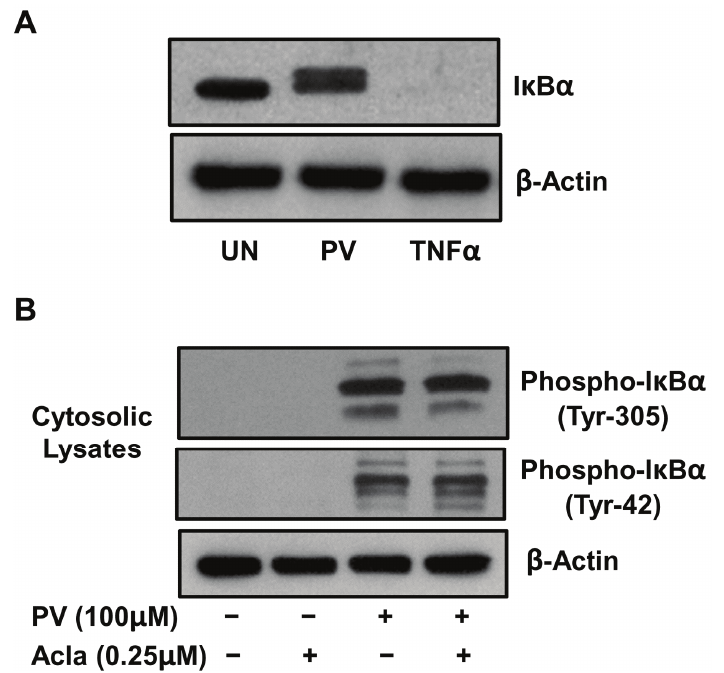
Figure 1. Pervanadate (PV) stimulation induces tyrosine phosphorylation of I(cid:2)B(cid:3) but not its proteolytic degradation. ( A ) ILU-18 cells were either left untreated or treated with Pervanadate (100 (cid:4)M) or TNF-(cid:3) (20 ng/mL) for 20 min. At the end of treatment, cytosolic lysates were obtained and 30(cid:4)g protein from each lysate was resolved by sodium dodecyl sulfate polyacrylamide gel electrophoresis (SDS-PAGE). Resolved proteins were detected by Western blotting using antibody to nuclear factor of kappa light polypeptide gene enhancer in B-cells inhibitor, alpha (I(cid:2)B(cid:3)) and enhanced chemiluminescence (ECL). The blot was stripped and re-probed with antibody to (cid:5)-actin to ensure equal protein loading. ( B ) ILU-18 cells were treated with PV (100 (cid:4)M) for 20 min, with or without prior treatment with Aclacinomycin [Acla] (0.25 (cid:4)M) for 2 h. At the end of incubation, cells were washed and cytosolic lysates prepared. As controls, cell lysates were made from ILU-18 cells either left untreated or treated for 140 min with 0.25 (cid:4)M Aclacinomycin alone. Lysates, equalized for 30 (cid:4)g protein, were resolved using SDS-PAGE, followed by Western blotting using a phospho-specific antibody recognizing I(cid:2)B(cid:3) (Tyr-42) or (Tyr-305). After stripping, the blot was re-probed with antibody to (cid:5)-actin to demonstrate equal protein loading. To elucidate whether PV-mediated NF-(cid:2)B activation occurs by a mechanism involving tyrosine phosphorylation, we next assessed if both in the absence and presence of proteasome inhibitor (Aclacinomycin), I(cid:2)B(cid:3) undergoes tyrosine phosphorylation [20]. By employing immunoblotting with an antibody recognizing phospho-I(cid:2)B(cid:3) (Tyr42 or Tyr305), we now demonstrate that PV induces tyrosine phosphorylation of I(cid:2)B(cid:3) at Tyr-42 and Tyr305, both in the absence and presence of proteasome inhibitor (Figure 1B). Overall, these results demonstrate that in response to PV stimulation, tyrosine phosphorylation of I(cid:2)B(cid:3) occurs, independently of proteasome catalytic